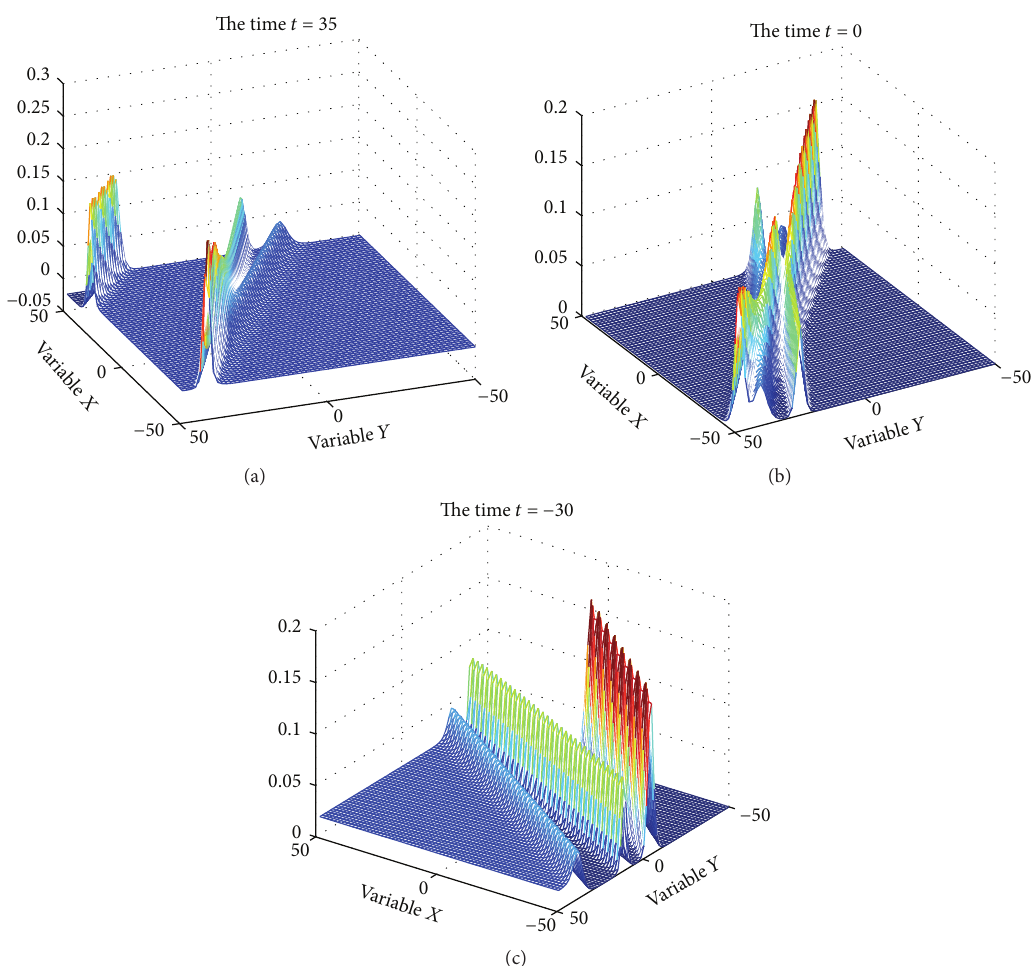
Figure 5: The process of (28) with 𝑘 1 = 0.8 , 𝑘 2 = 0.6 , 𝑘 3 = 0.4 , 𝑝 1 = 1.25 , 𝑝 2 = 2 , 𝑝 3 = 1.5 , 𝑐(𝑡) = 30 , 𝑏(𝑡) = 1 , and ℎ(𝑡) = 1 , and (a) implies 𝑡 = 35 , (b) implies 𝑡 = 0 , and (c) implies 𝑡 = −30